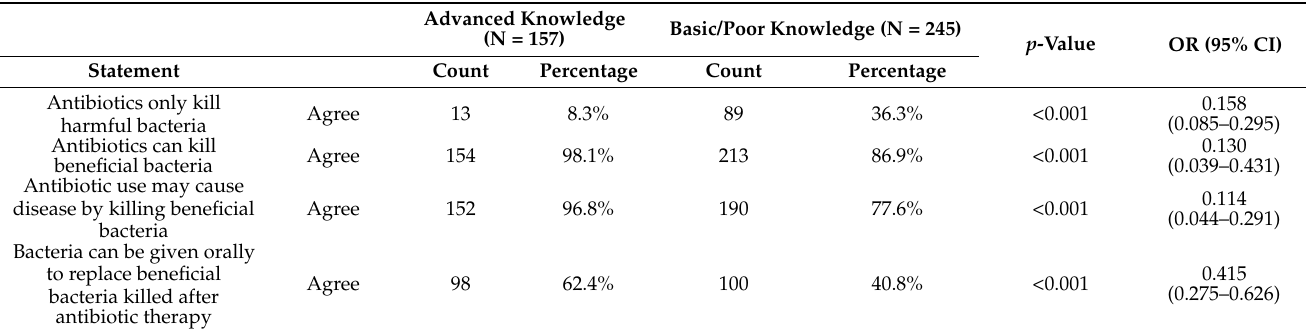
Table 4. Knowledge of the relationship between antibiotics and microbiota according to knowledge